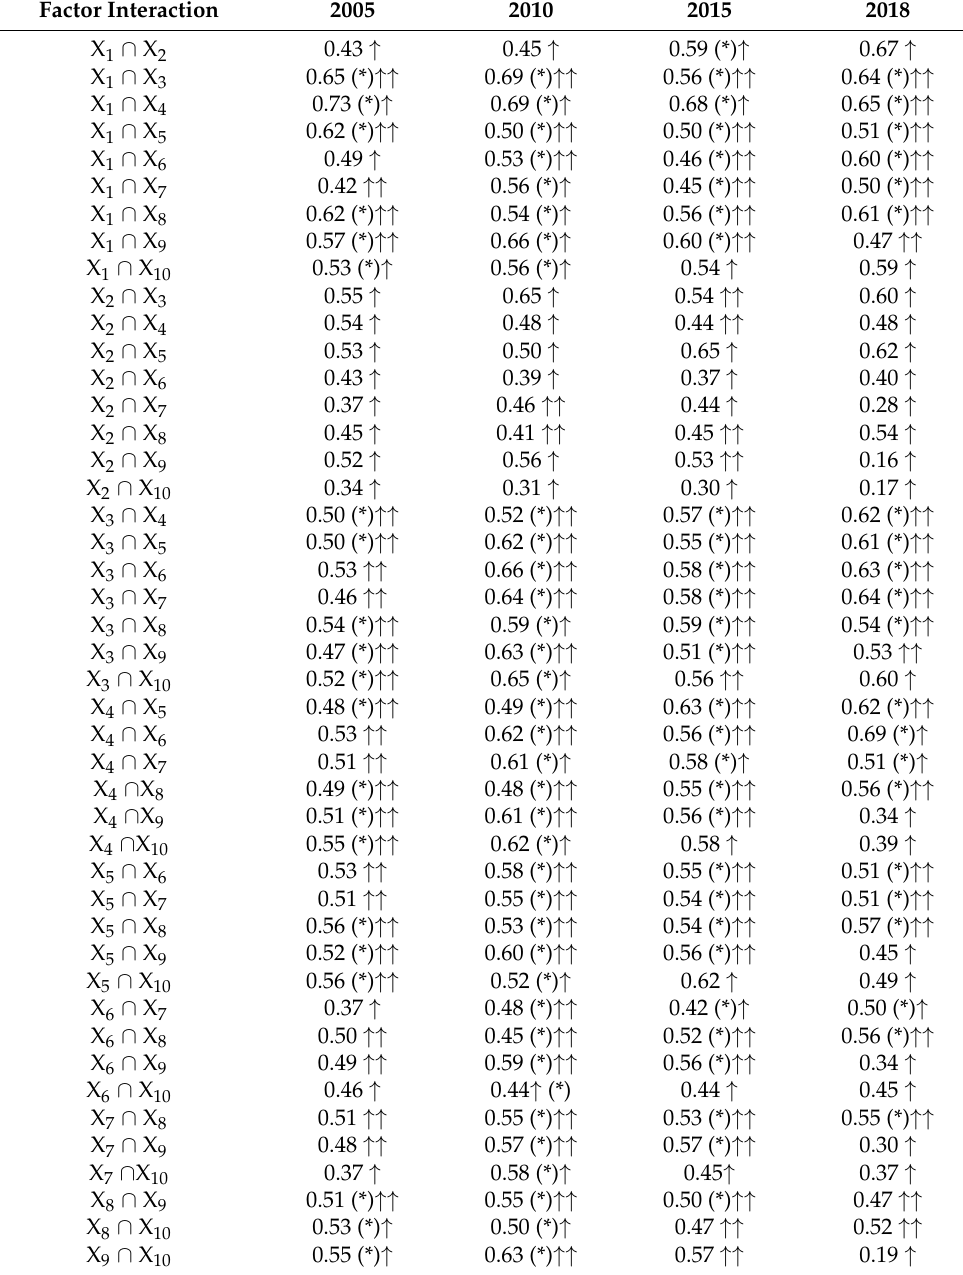
Table 7. Factor interaction detection results of CLE in